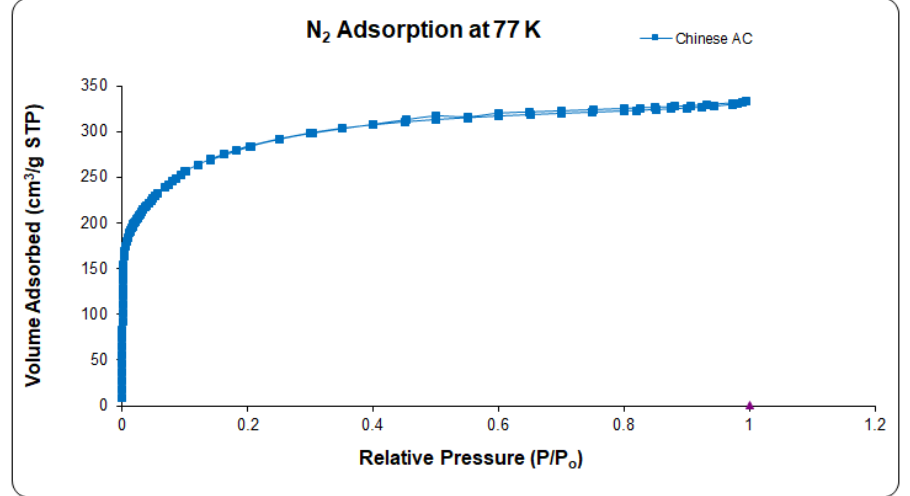
Figure 3. Adsorption-desorption isotherms of N 2 at 77 K for the Figure 3. adsorption-desorption isotherms of N 2 at 77 K for the AC.